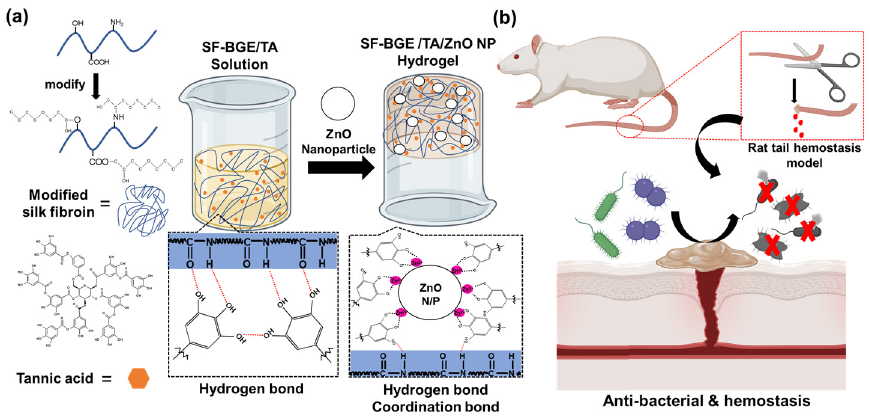
Figure 1. ( a ) Schematic of the modified SF (SF-BGE), tannic acid (TA), ZnO nanoparticles (NPs), SF- BGE/TA solution, and SF-BGE/TA/ZnO hydrogel hemostasis. ( b ) Schematic of the hemostasis trials in the rat tail amputation model and antibacterial and hemostatic process of SF-BGE/TA/ZnO